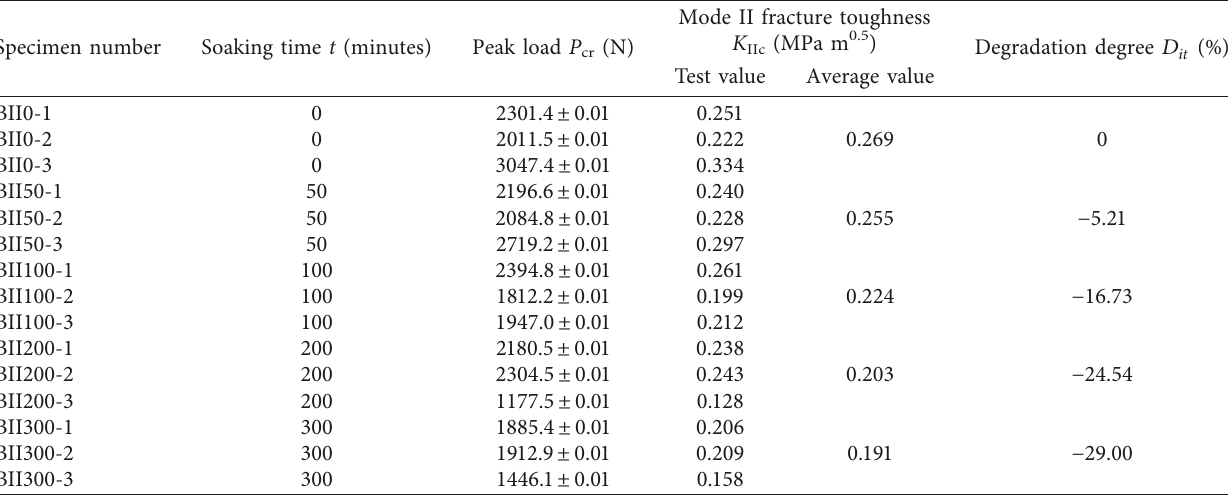
Table 6: Mode II fracture toughness of Type B mudstone specimens for different soaking times.